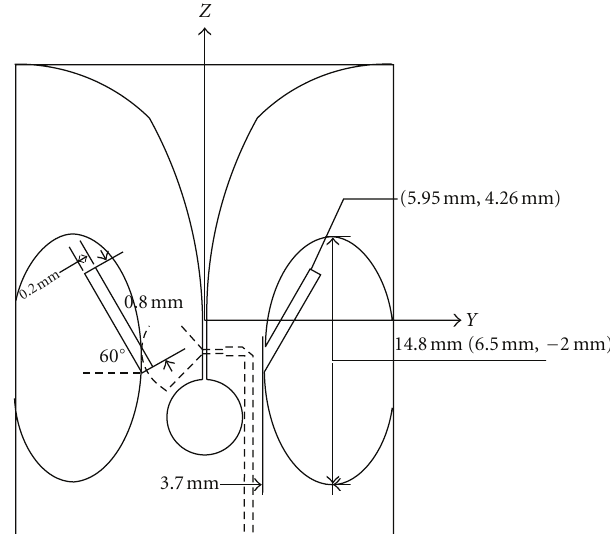
Figure 3: Structure of stealth